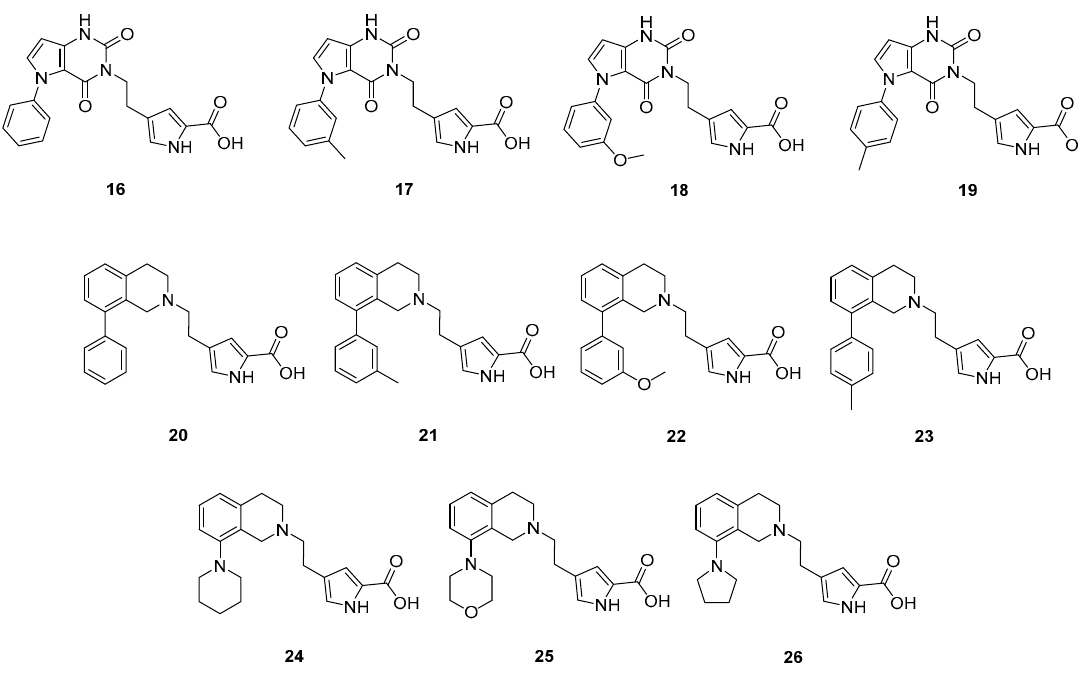
Figure 7. Prepared compounds with new linker part.